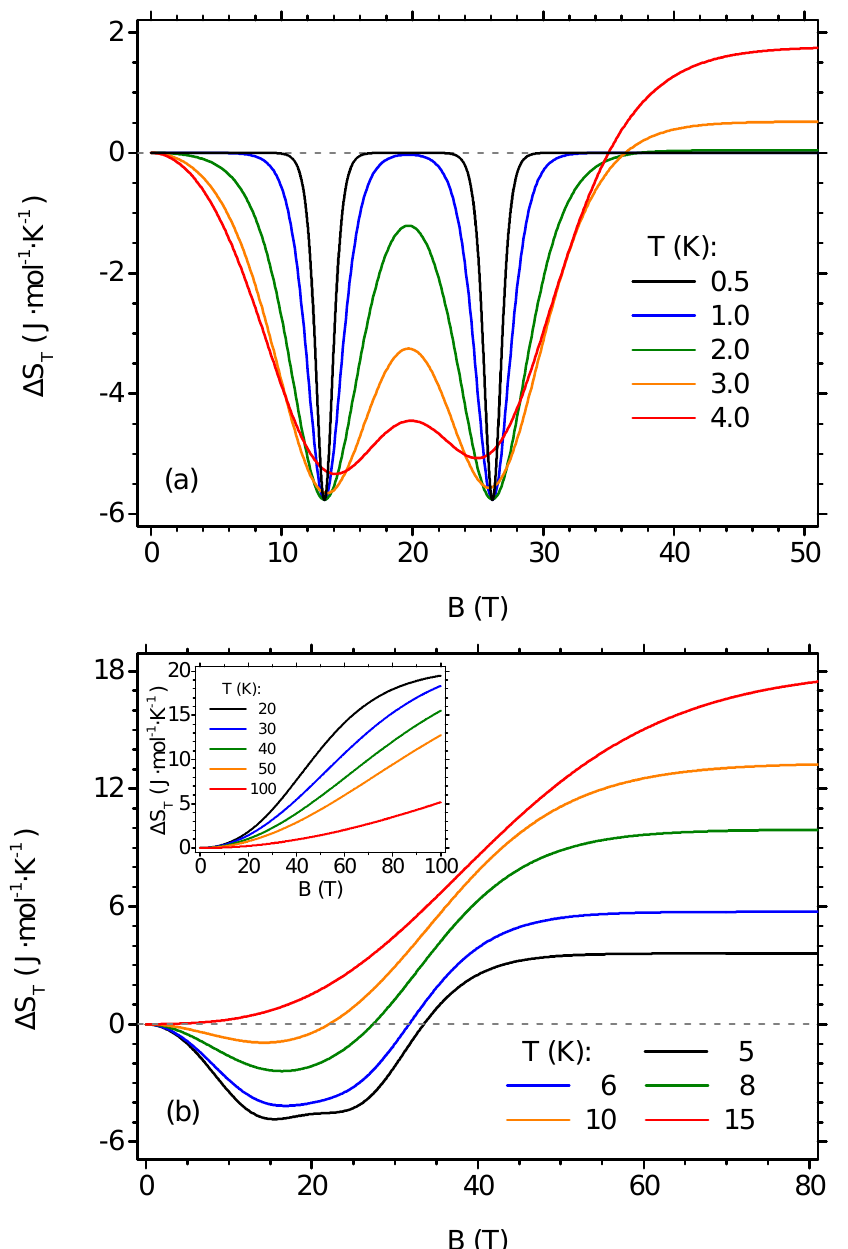
Figure 6. The dependence of the isothermal entropy change per mole on the initial value of the external magnetic field in the isothermal process (the final value of the magnetic field is zero), for selected temperatures. ( a ) low-temperature range; ( b ) higher temperature